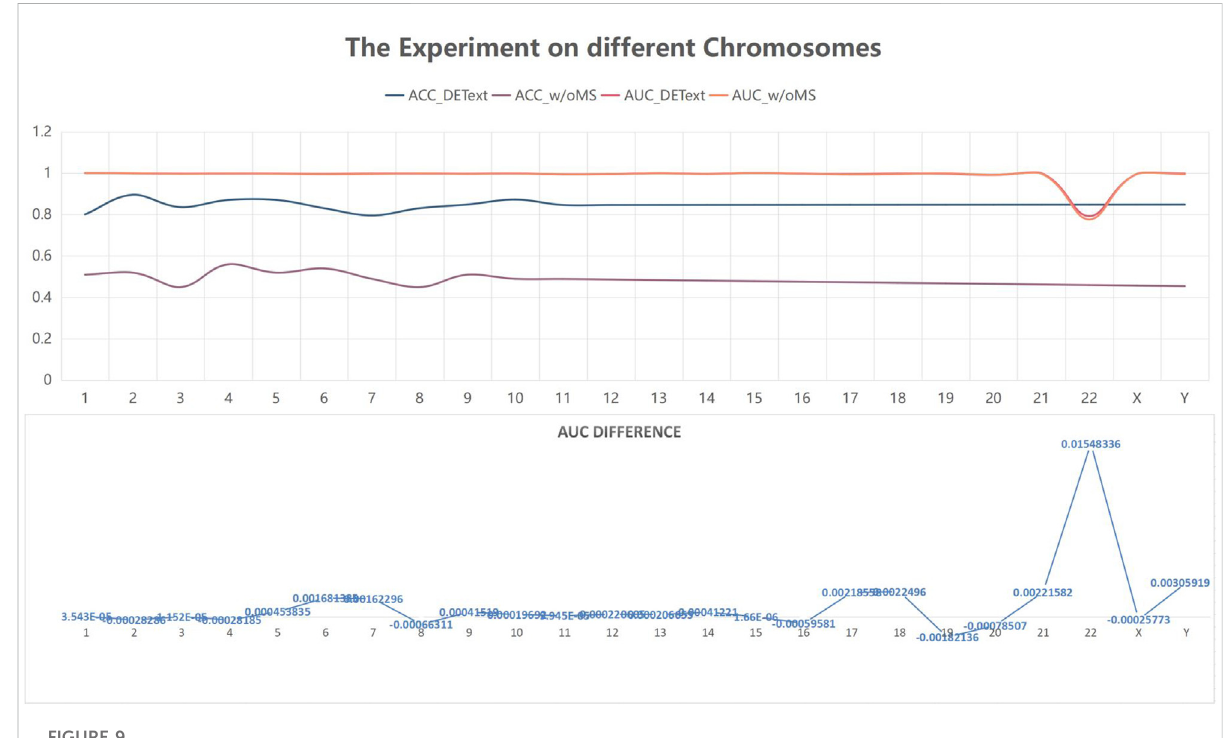
FIGURE 9 Experimentondifferentchromosomes.Theeffectofmutationalsignaturesoneachchromosome.Theoverallperformanceofthemethodwas good, whereas the effects of mutational signatures on different chromosomes are slightly